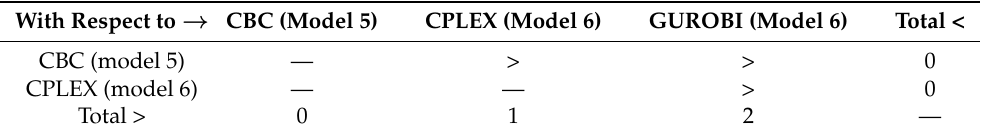
Table 5. Comparison of fastest models for each solver to solve a medium instance (ten agents, fifteen jobs) with unpaired two-sample Wilcoxon